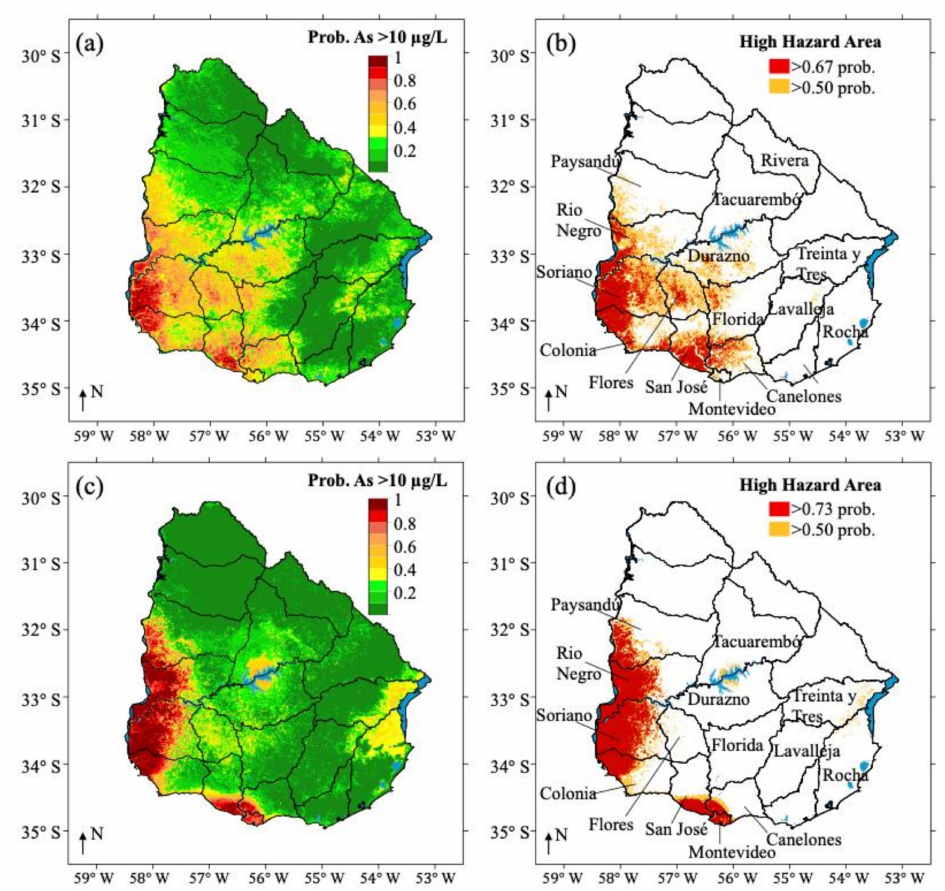
Figure 3. Hybrid machine learning models of Uruguay groundwater arsenic concentrations in shallow (2A-HML-Shal; ≤ 50 m) and deep (2B-HML-Deep; >50 m) aquifers. Shallow aquifers: ( a ) map of probability of groundwater arsenic concentrations exceeding 10 µ g/L; ( b ) map of high groundwater arsenic hazard areas (defined here by a probability exceeding cutoff values of 0.50 or 0.67); deep aquifers: ( c ) map of probability of groundwater arsenic concentrations exceeding 10 µ g/L; ( d ) map of high groundwater arsenic hazard areas (defined here by a probability exceeding cutoff values of 0.50 or